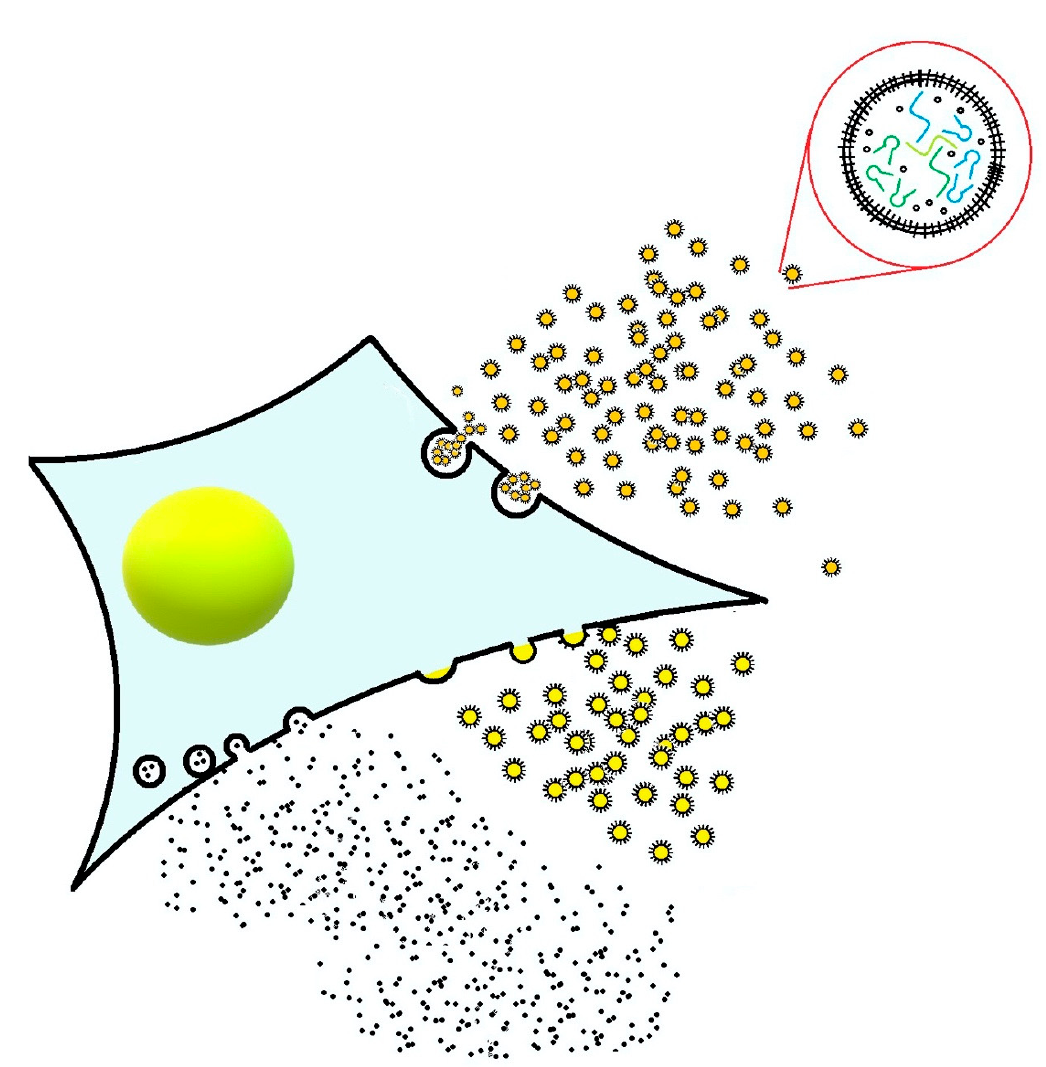
Figure 3. Illustration of the MSC secretome and the biogenesis of extracellular vesicles (EVs) either by direct budding from the plasma membrane or by fusion of multivesicular endosomes with the plasma membrane. The secretome is composed of soluble and vesicular (EVs) proteins, lipids, RNA (mRNA and noncoding RNAs) and DNA and influences diverse biological functions, including the immune response, endogenous cell homing and cell differentiation.